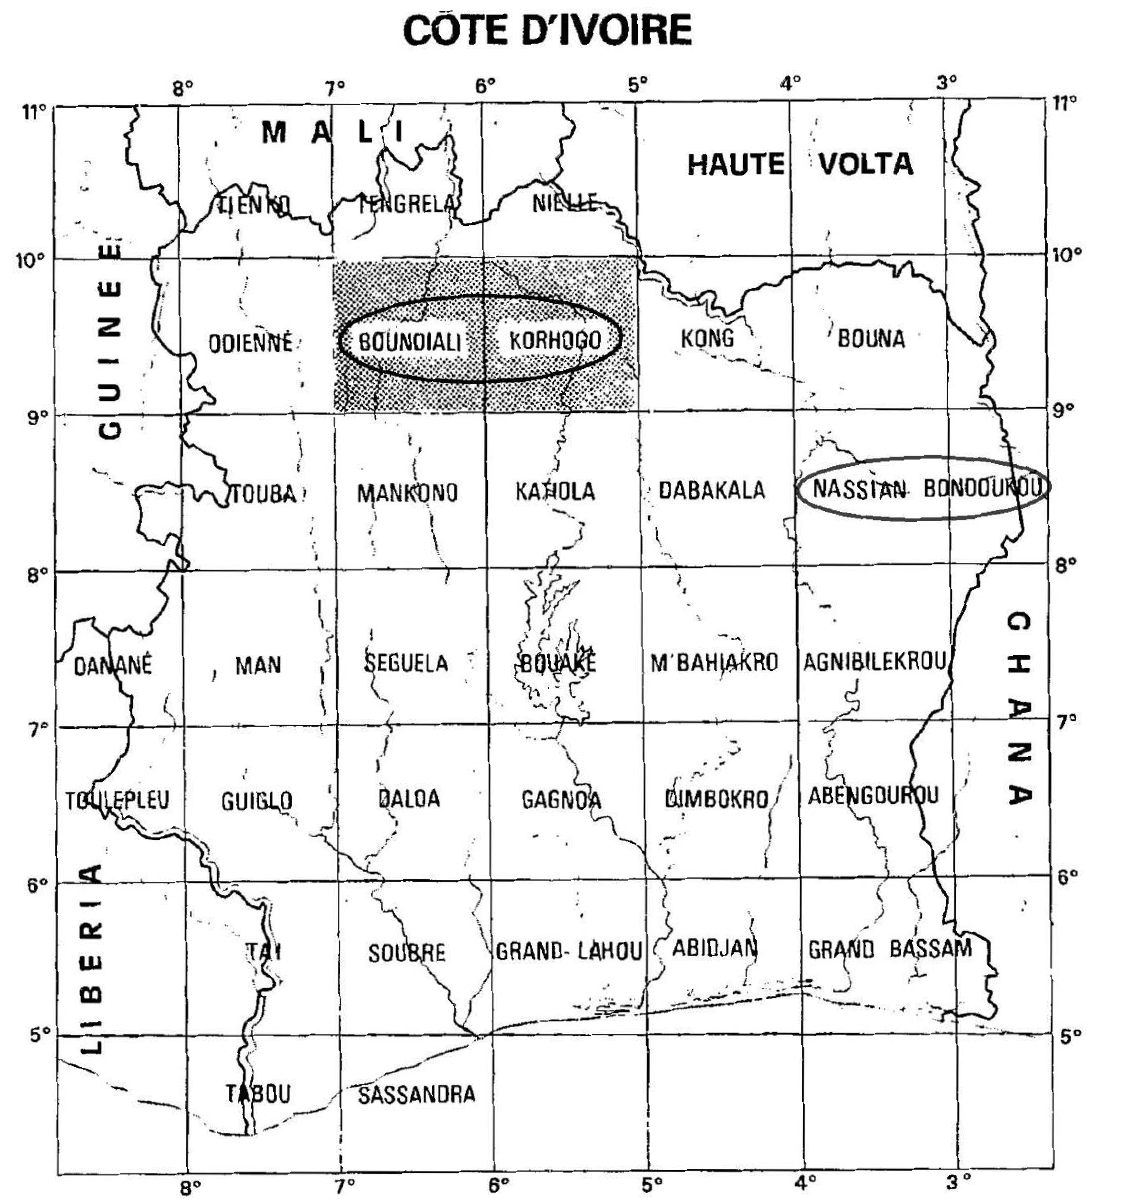
Figure 1: Côte d’Ivoire’s map showing the North and Northeast regions (Beaudou (1980), modified)